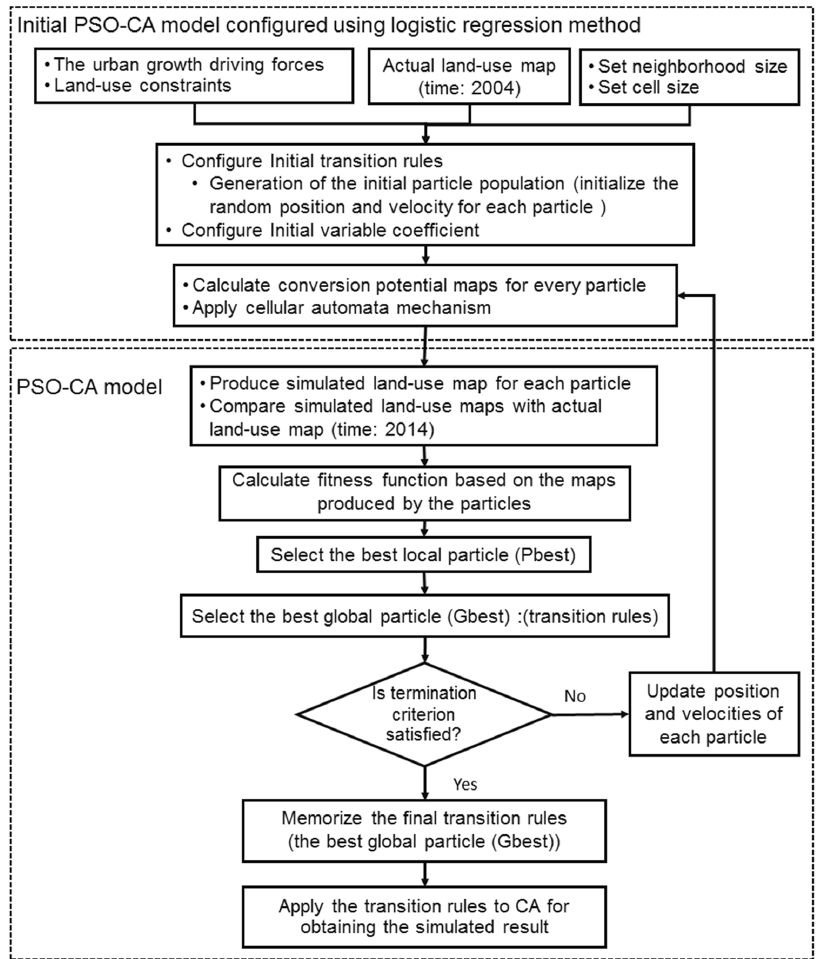
Figure 2. The proposed PSO-CA model. PSO, particle swarm optimization.